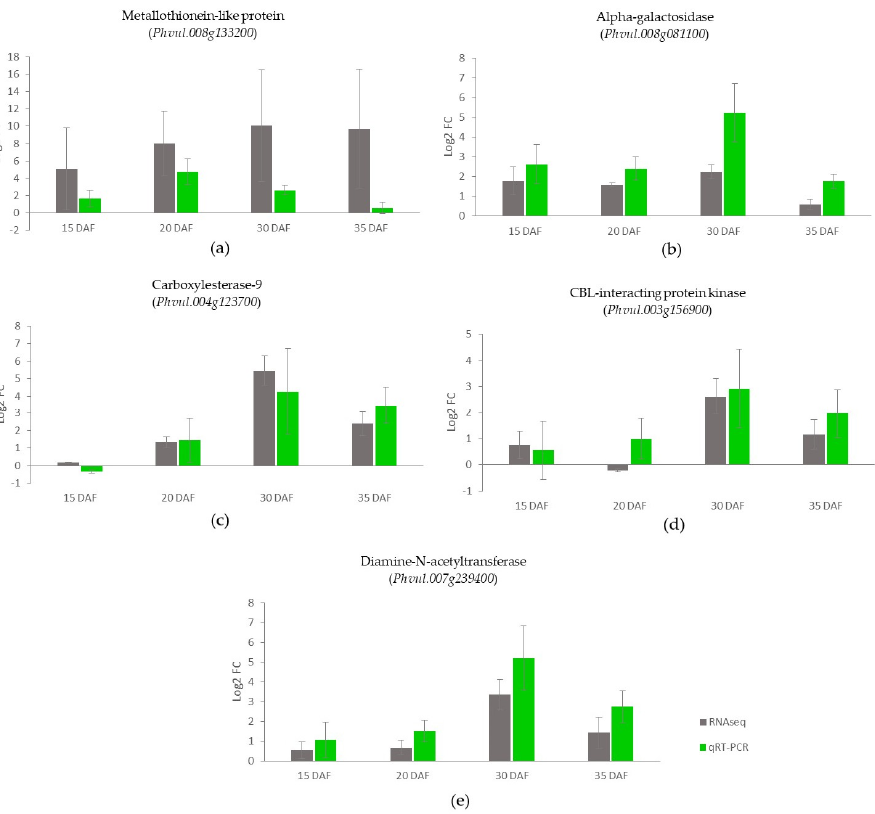
Figure 10. Comparison of RNA sequencing and qRT-PCR methods for analyzing the gene expression in the slow-cooking bean (Pinto) against the fast-cooking bean (Rosecoco). The bar graphs ( a – e ) show the gene expression of selected highly expressed genes in the slow-cooking bean. Gene-expression values are presented with log2 fold change (Log2FC) normalization. B-tubulin was used as the housekeeping gene for gene-expression normalization [53]. Error bars represent the standard error within samples.